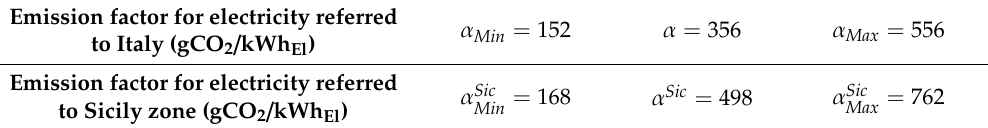
Table 2. Minimum, maximum and average emission factors for electricity referred to Italy and Sicily